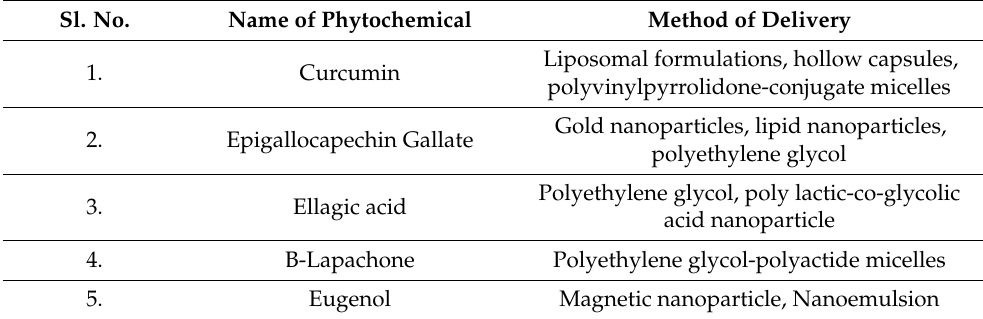
Table 2. Table representing a few of the applications of nanoformulated phytochemicals in colon cancer